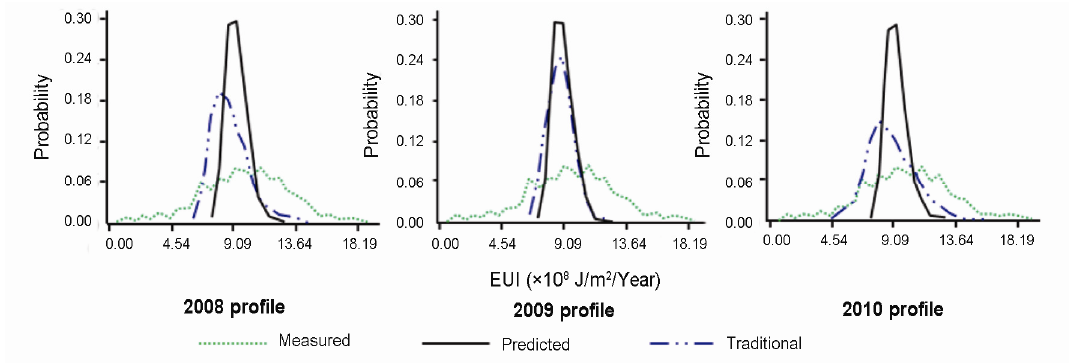
Fig. 18. Comparison of results of different